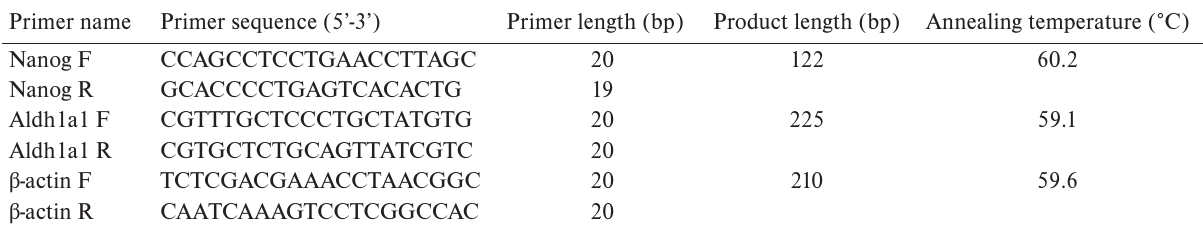
Table 1. Primers used in this